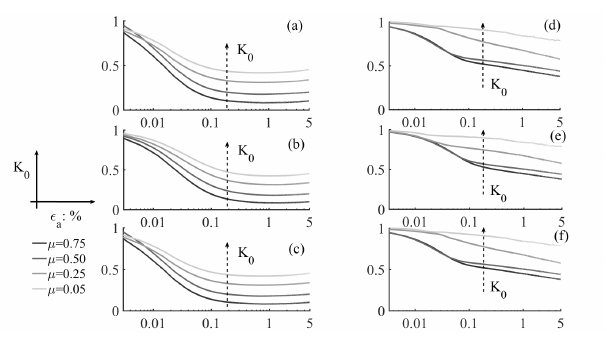
Figure 3. Dependency of macro-scale responses on